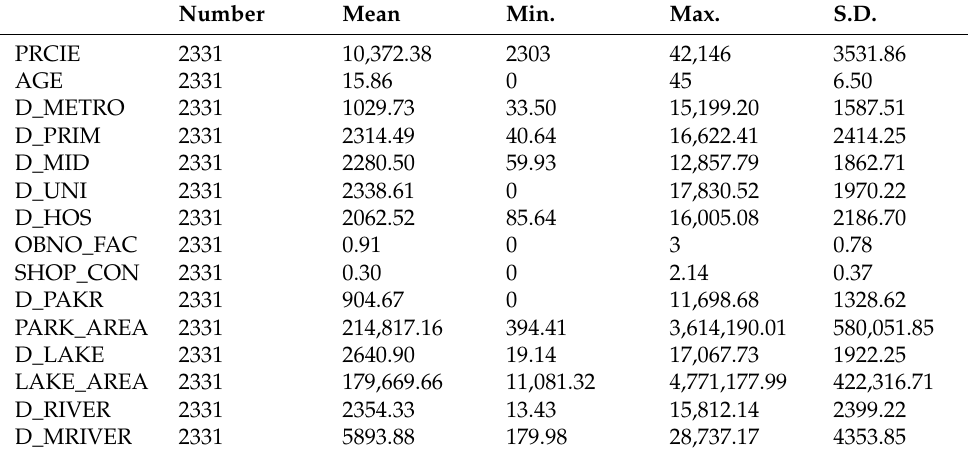
Table A5. Descriptive statistics of data in Shenyang.